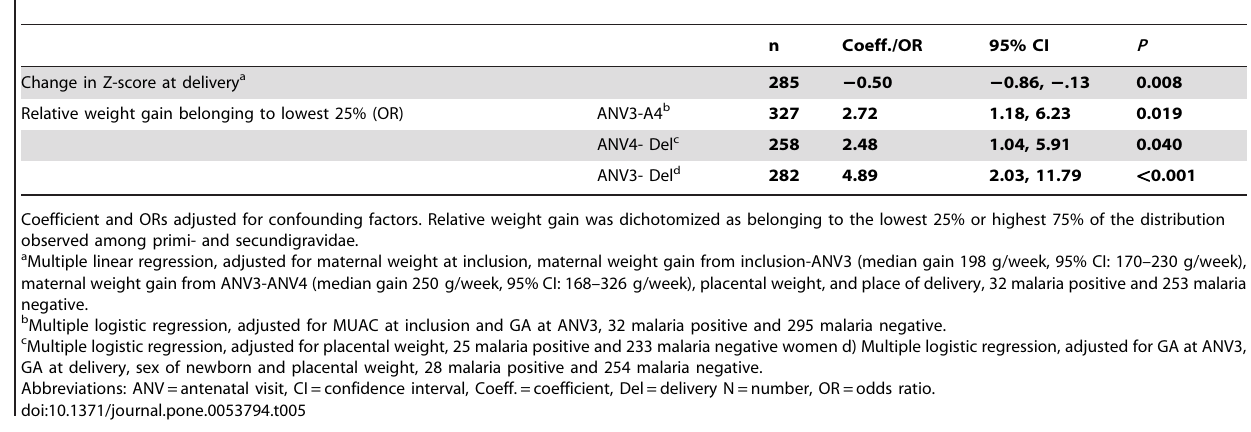
Malaria positive a (n=48) Malaria negative a (n=350)